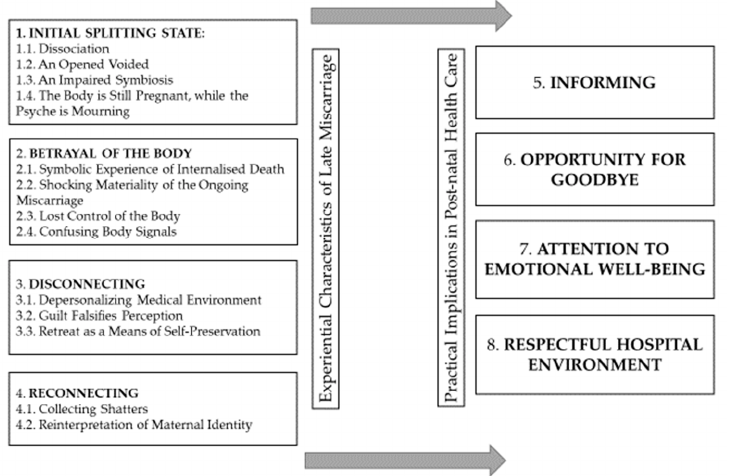
Figure 1. Thematic model: experiential characteristics of late miscarriage and practical implications in post-natal health care.